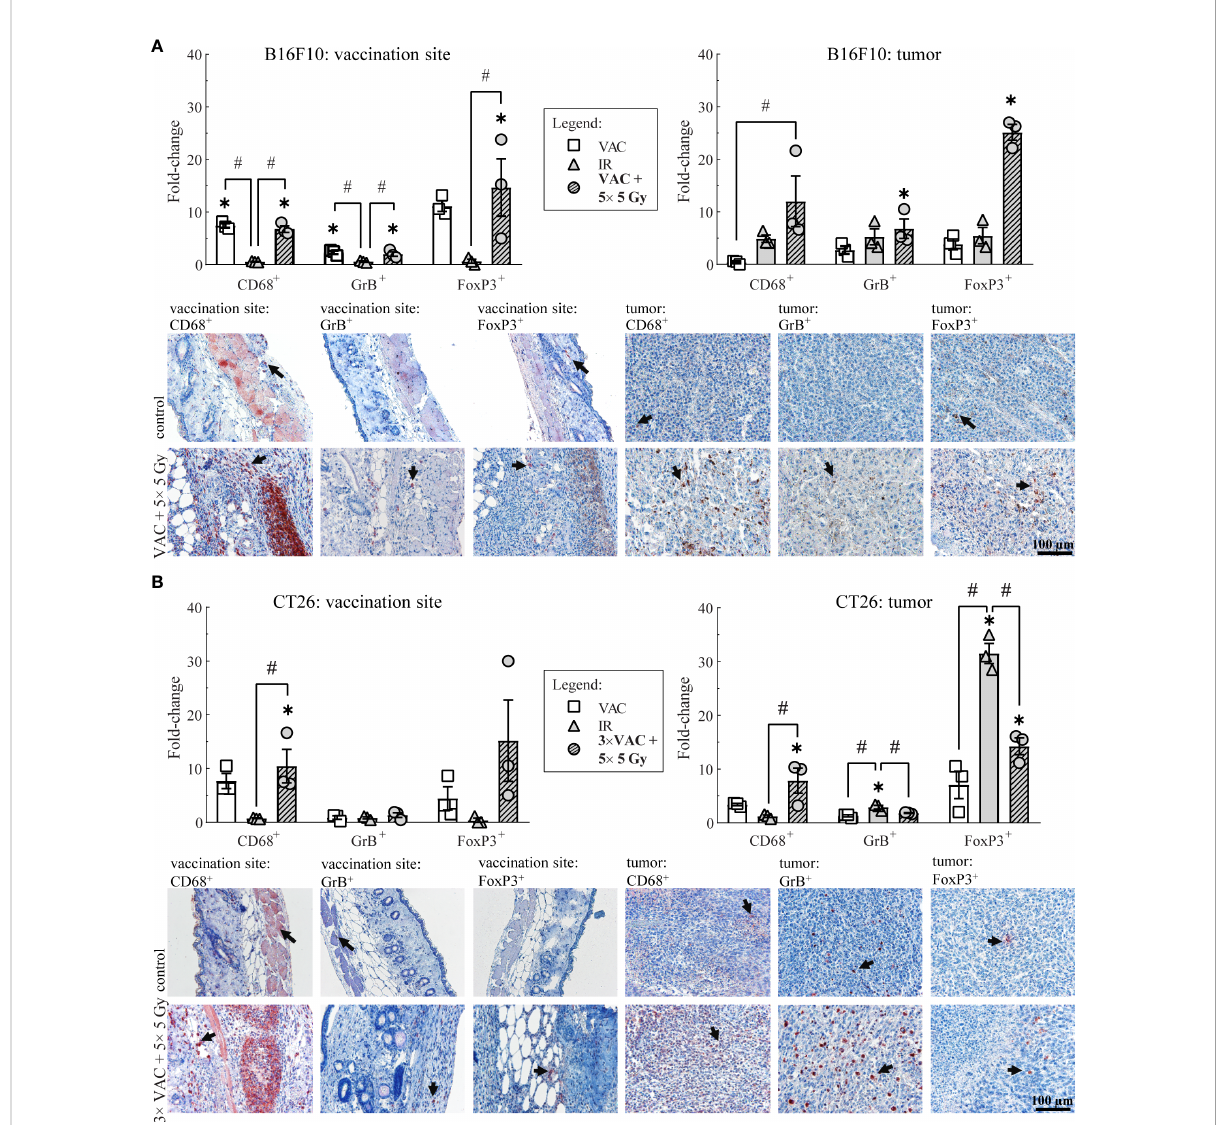
FIGURE 3 Histological analysis of skin at the site of vaccination and tumors on day 6. (A) Immune cell in fi ltration in the skin at the site of vaccination and in B16F10 tumors. Representative images of the control (untreated mice) and the combinatorial treatment (VAC + 5× 5 Gy) groups are shown underneath the graphs. (B) Immune cell in fi ltration in the skin at the site of vaccination and in CT26 tumors. Representative images of the control (untreated mice) and the combinatorial treatment (VAC + 5× 5 Gy) groups are shown underneath the graphs. Legend: the black arrows in the images indicate examples of cells positive for CD68, GrB or FoxP3 markers; the scale bar for all images is shown in the lower left corner image: 100 µm; *p < 0.05 versus the control group; # p < 0.05 between the annotated treatment groups: VAC, selected concomitant single- and multi-dose vaccinations for B16F10 and CT26 tumor models, respectively; IR, selected 5× 5 Gy IR